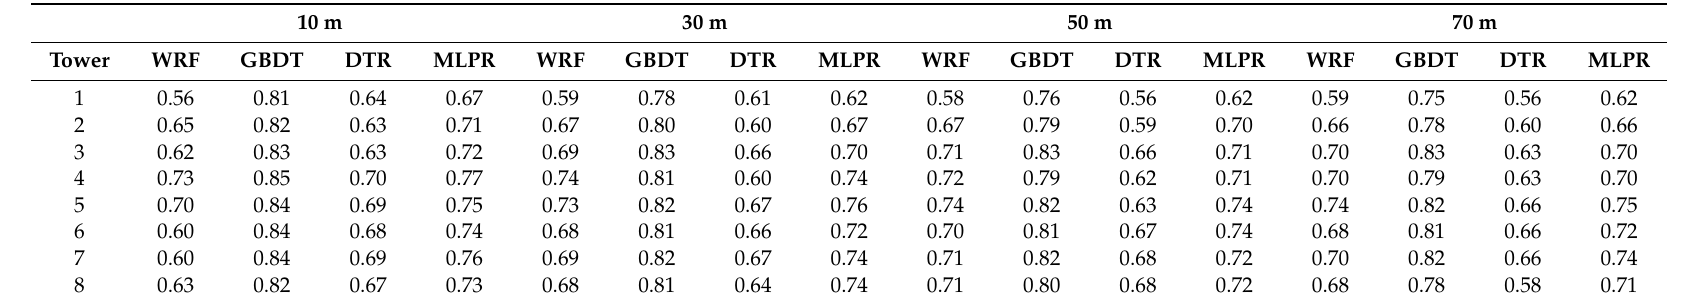
Table A5. The 24–48 h IA of WRF model original output and post-processing model